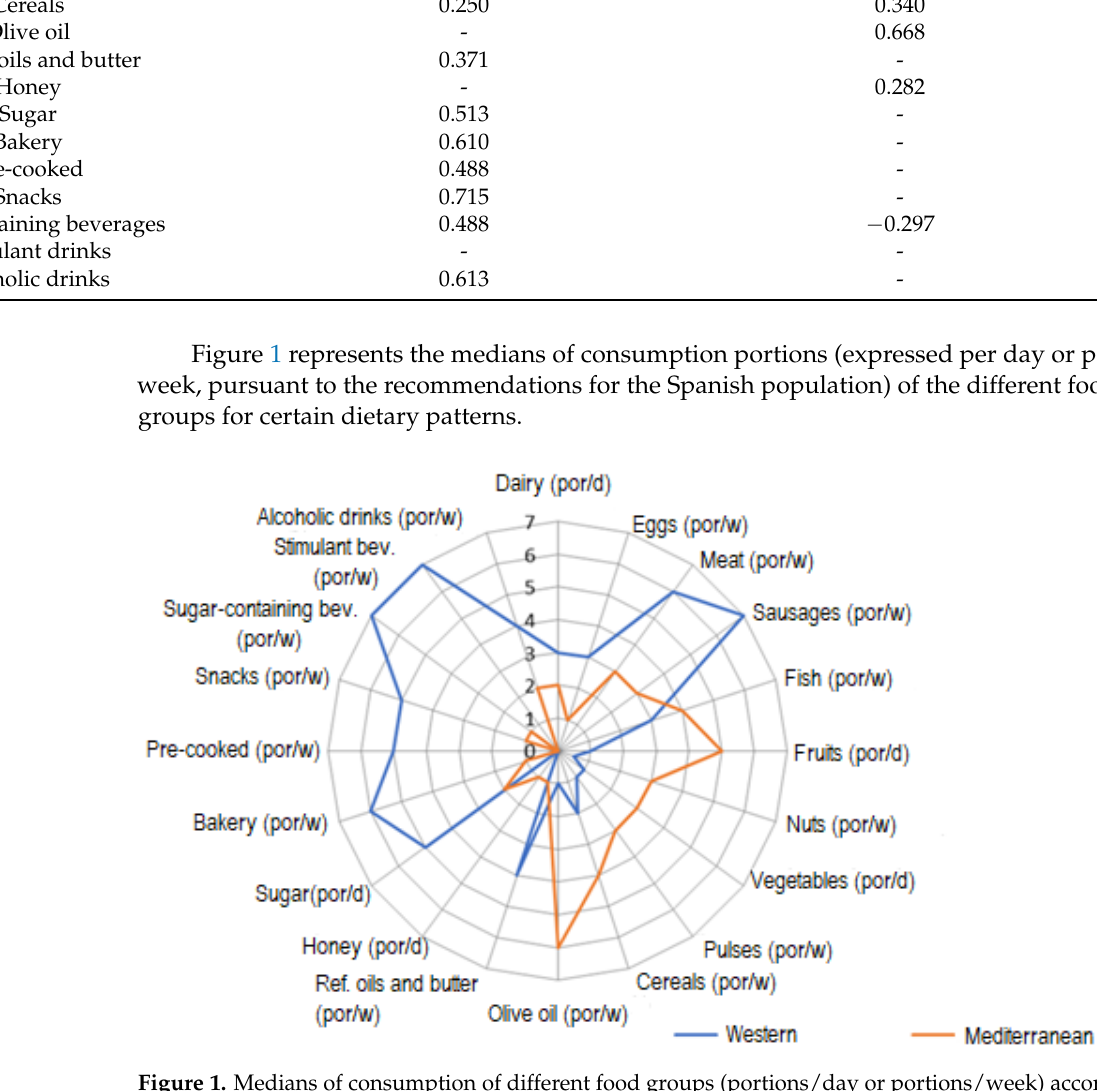
Figure 1. Medians of consumption of different food groups (portions/day or portions/week) accord- ing to the scores reached in the Western pattern (Factor 1) and Mediterranean pattern (Factor 2). The distribution of university professors according to their adherence to Western and Mediterranean diet patterns (tertiles), sex, bachelor’s degree, nutritional status, and physical activity level is reflected in Tables 4 and 5. From the associations studied, for the Western pattern, significant differences are observed as regards origin ( p = 0.022) and physical activity level ( p = 0.010). In the Mediterranean pattern case, significant differences are only observed with respect to the centre where they teach ( p =